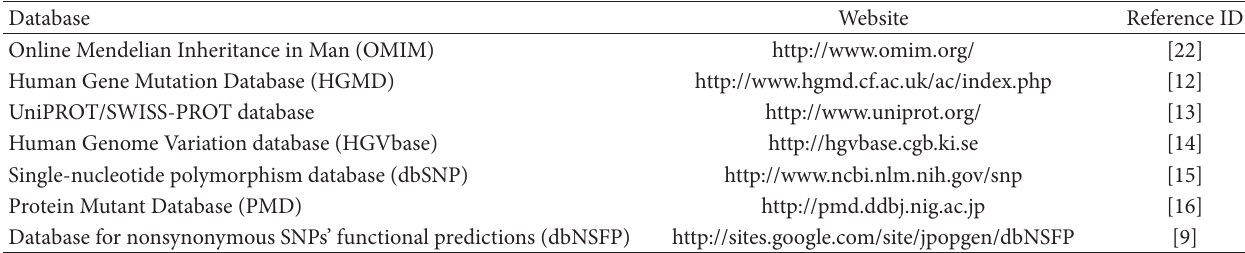
T 1: Database for collecting nsSNP data.